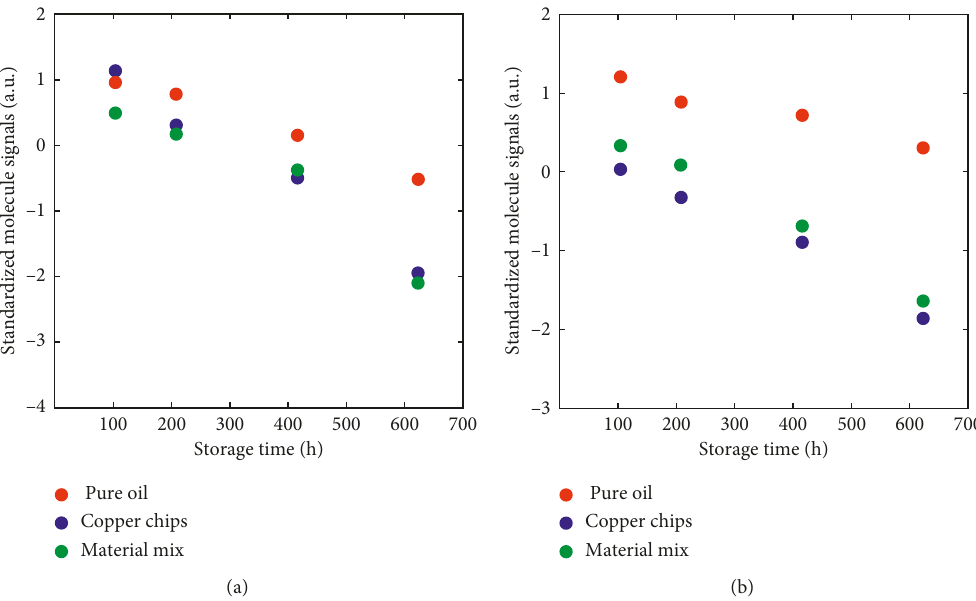
Figure 3: Standardized additive responses used as target value for the FTIR regression model for (a) the friction modifier compound and (b) the antioxidant plotted against time for storage temperature 140 ° C for all three storage experiments measured by